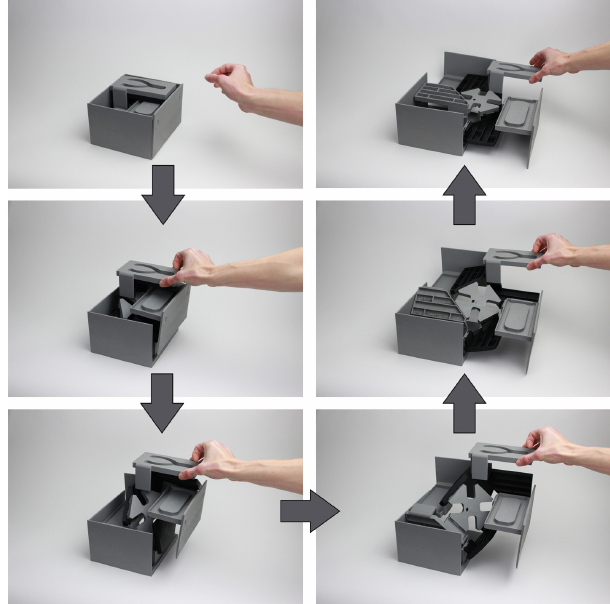
Figure 11. A demonstration of the motion of the toolbox.